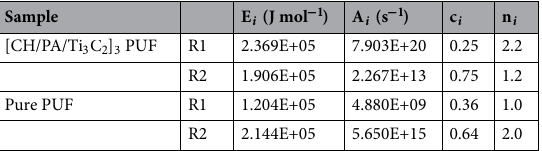
Table 2. Pyrolysis reaction rate kinetics for pure PUF and coated PUF.